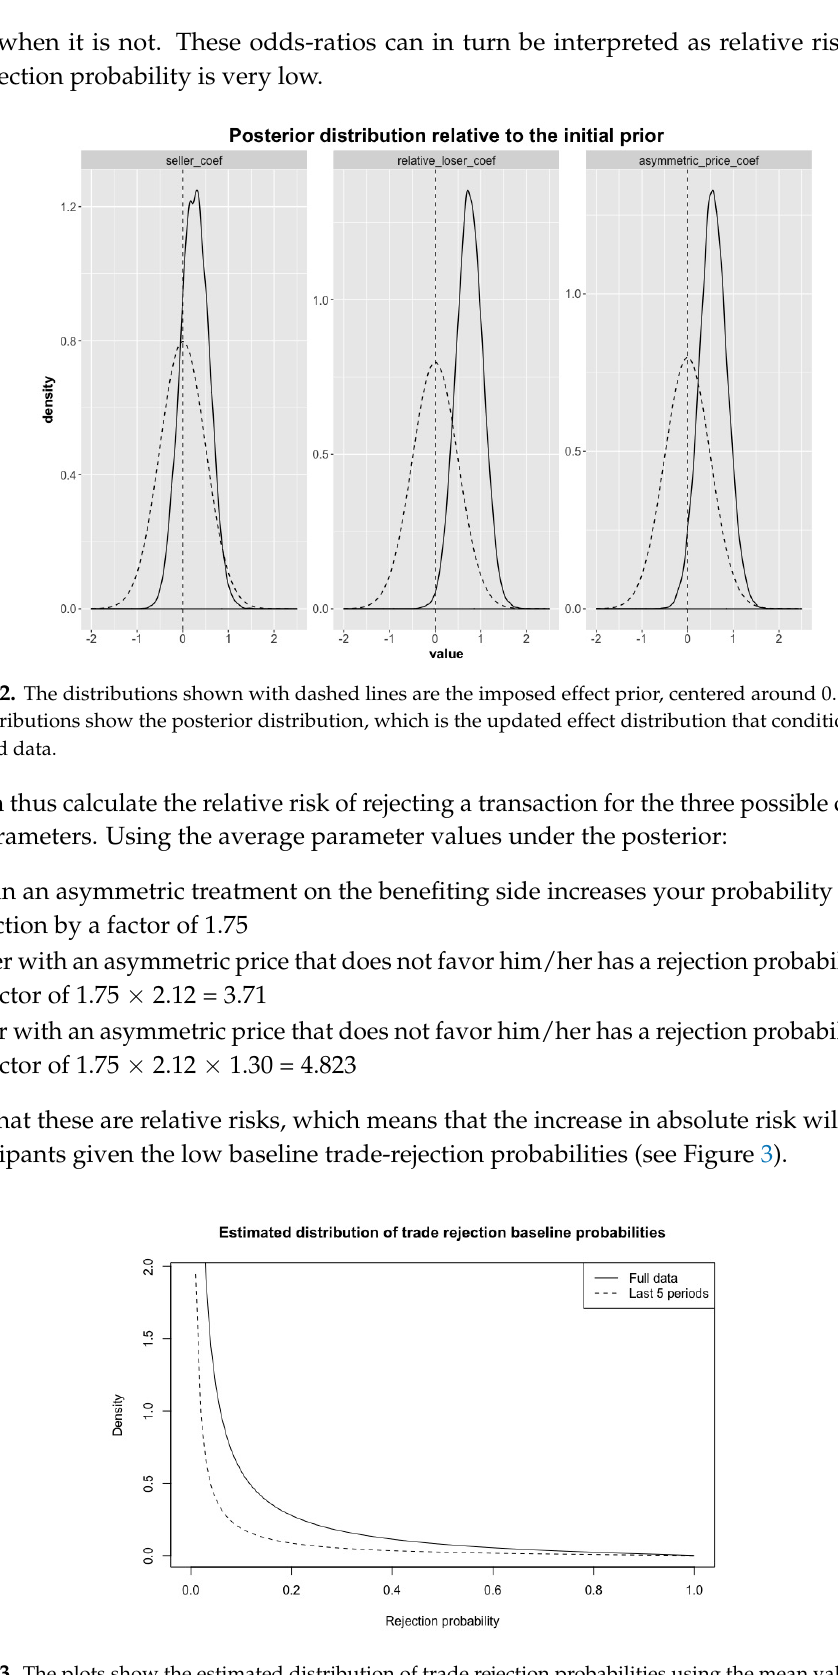
Figure 3. The plots show the estimated distribution of trade rejection probabilities using the mean values of the estimated beta coefficient from the posterior distribution. Estimates using the full data set and the last five rounds of the experiment are shown